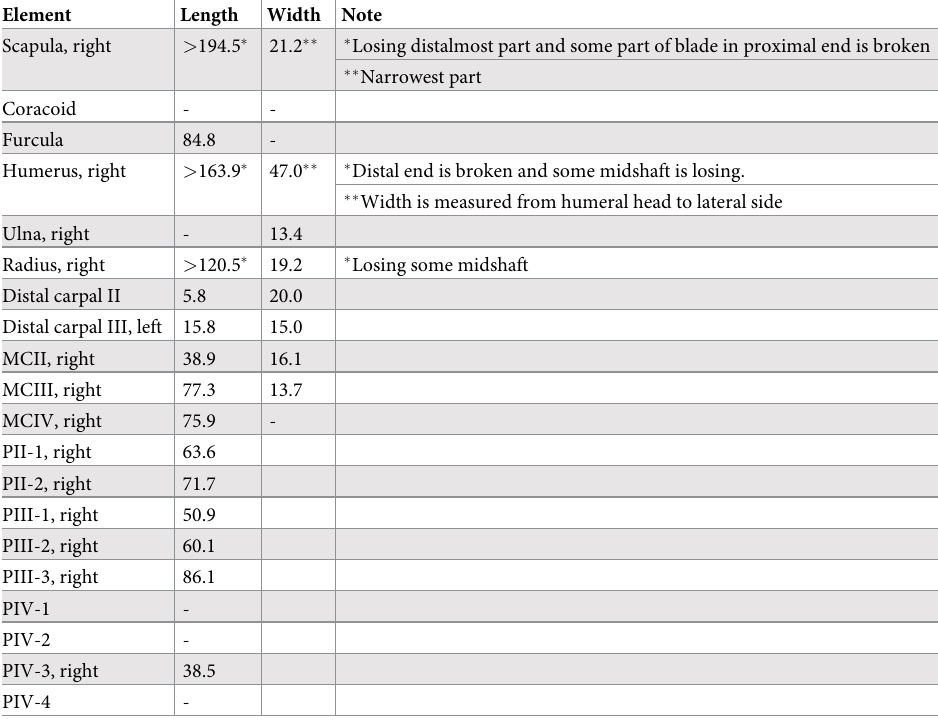
Table 2. Measurements in millimeters of pectoral girdle and forelimb elements of B . inexpectus (IVPP V 11559). Element Length Width Note Scapula, right > 194.5 � 21.2 �� � Losing distalmost part and some part of blade in proximal end is broken �� Narrowest part Coracoid - - Furcula 84.8 - Humerus, right > 163.9 � 47.0 �� � Distal end is broken and some midshaft is losing. �� Width is measured from humeral head to lateral side Ulna, right - 13.4 Radius, right > 120.5 � 19.2 � Losing some midshaft Distal carpal II 5.8 20.0 Distal carpal III, left 15.8 15.0 MCII, right 38.9 16.1 MCIII, right 77.3 13.7 MCIV, right 75.9 - PII-1, right 63.6 PII-2, right 71.7 PIII-1, right 50.9 PIII-2, right 60.1 PIII-3, right 86.1 PIV-1 - PIV-2 - PIV-3, right 38.5 PIV-4